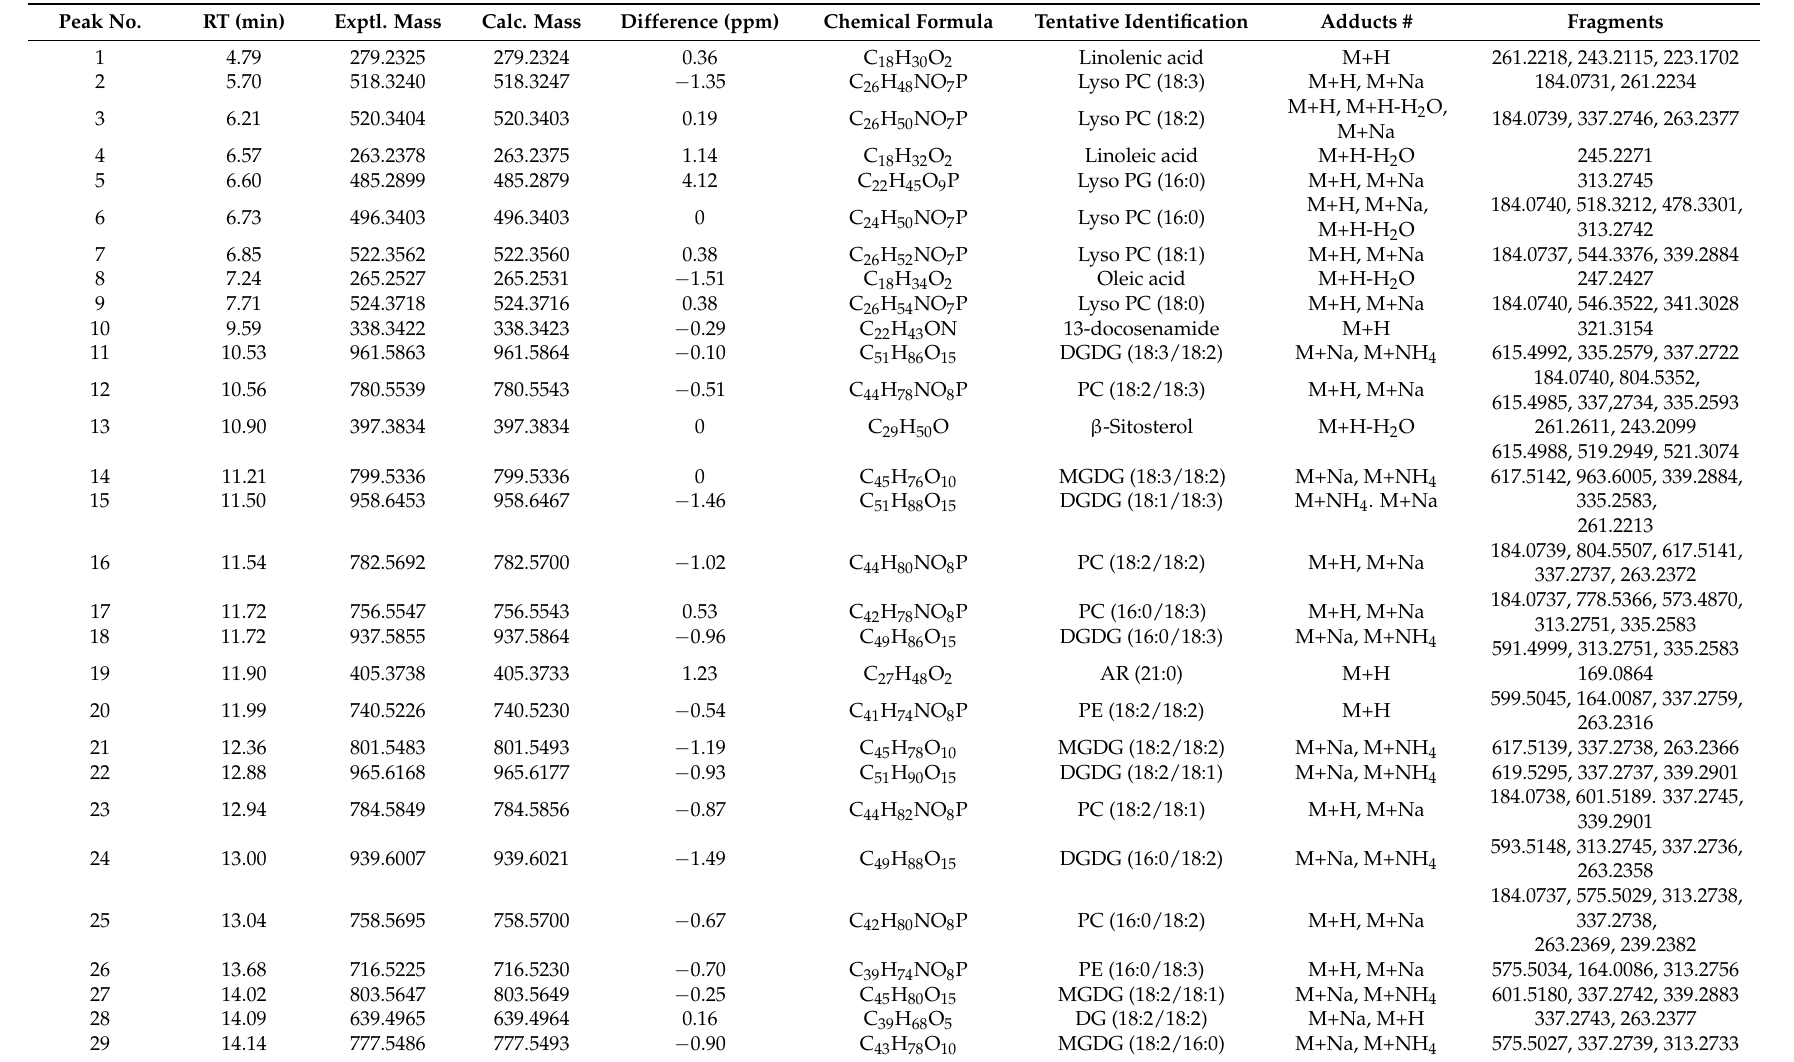
Table 1. Chemical compounds identification of QC * wheat